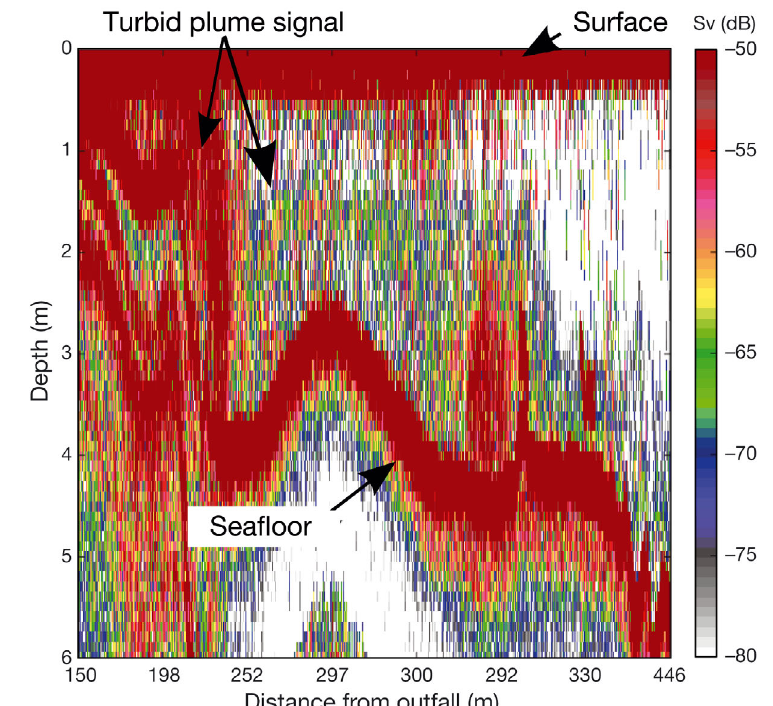
Fig. 5. High-resolution echogram measured ~300 m from the outfall shows the plume’s turbid signal leaving the surface to form a layer above the bottom. Fig. 2c shows where this echogram was taken